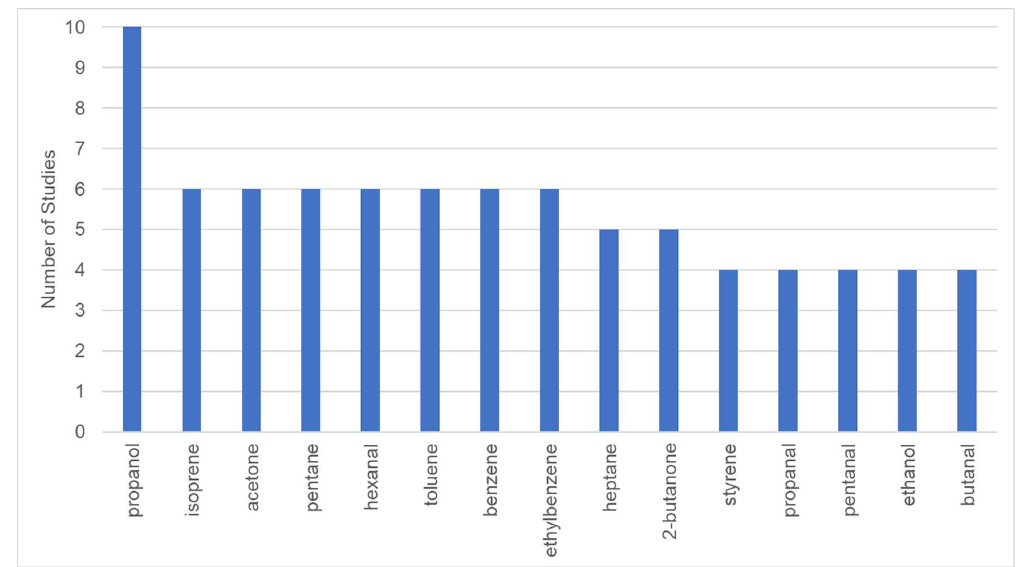
Figure 1. Volatile organic compounds (VOCs) identified as lung cancer biomarker in four or more studies.